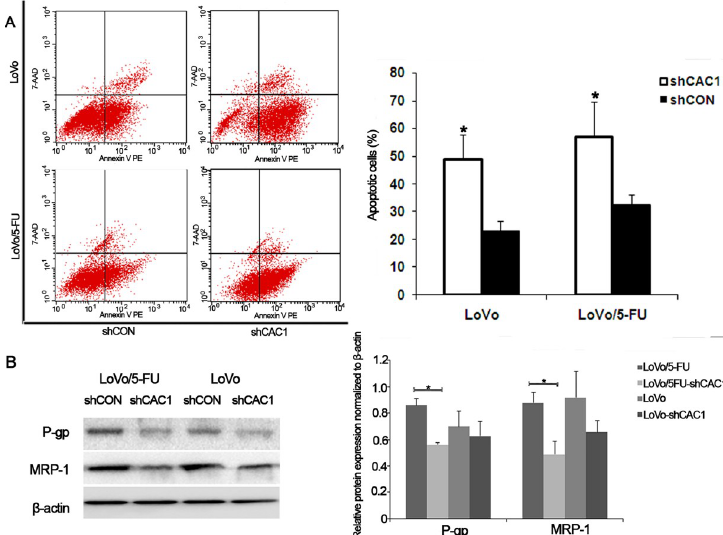
Fig 5. CAC1 knockdown increased sensitivity of LoVo/5-FU cells to 5-FU by influencing P-glycoprotein and MRP-1 expression. (A) LoVo and LoVo/5-FU cells transfected with shCAC1 and shCON were subjected to FACS analysis with Annexin V-FITC and propidium iodide staining. (B) The expression of drug resistance-associated proteins, P-glycoprotein and MRP-1, in LoVo and LoVo/5-FU cells after transfection with shCAC1 and shCON was examined by western blot. � P < 0.05, �� P <